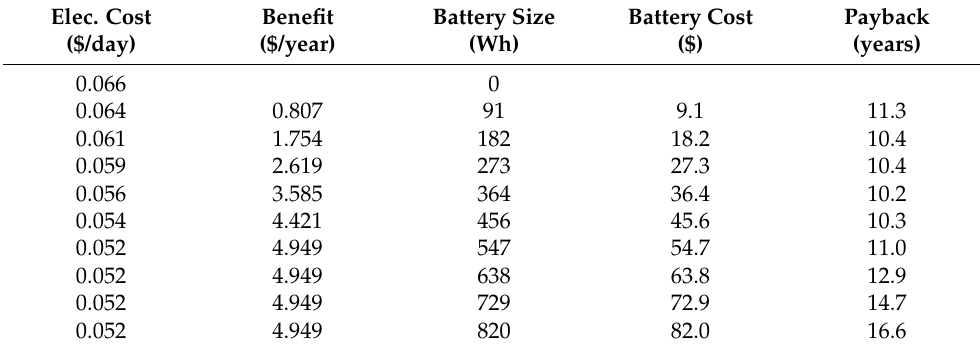
Table 4. Capacity Decision: Refrigerator, TOU, Case 2.